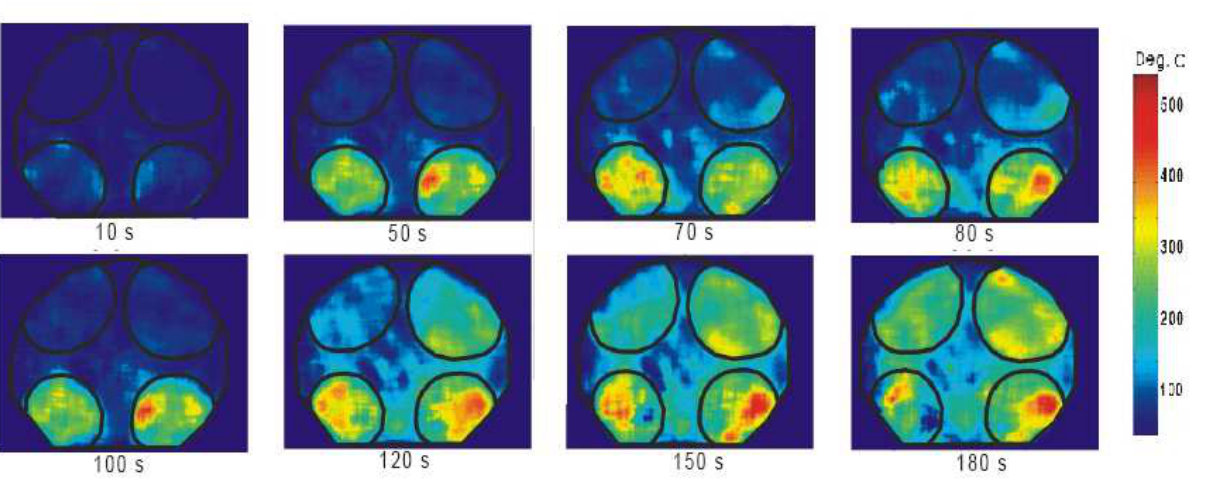
Figure 58. Temperature images of the intake(upper quadrant) and exhaust values(lower quadrant) measured using thermographic phosphors